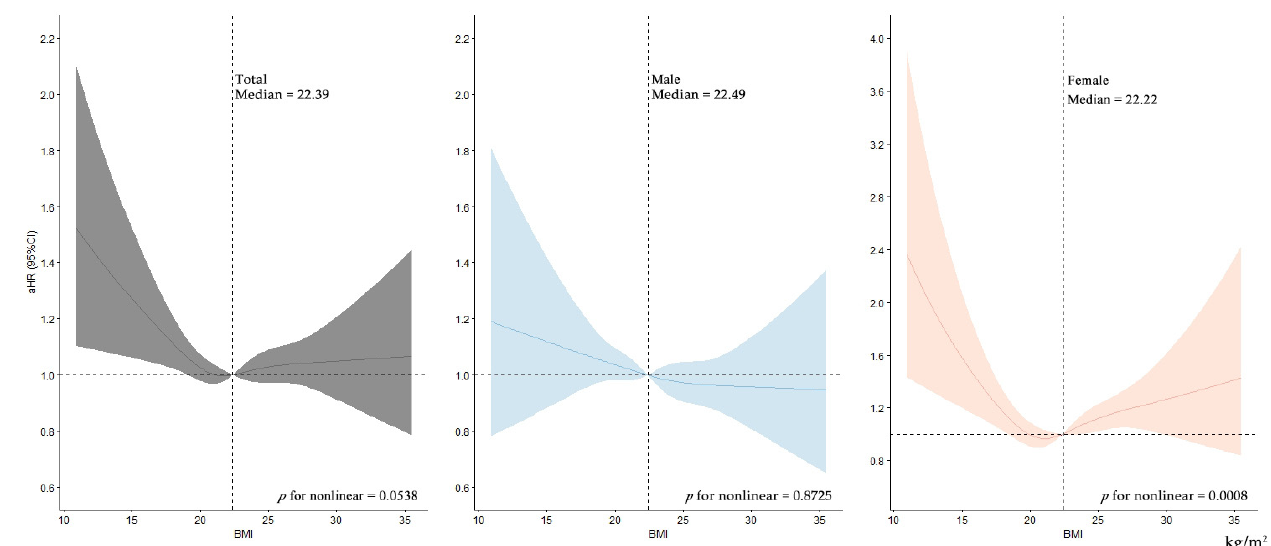
Figure 2. Restricted cubic splines analyses for association between BMI and risk of CHE stratified by gender. Notes: BMI: body mass index; aHR: adjusted hazard ratio; CI: confident interval. aHR (95%CI)